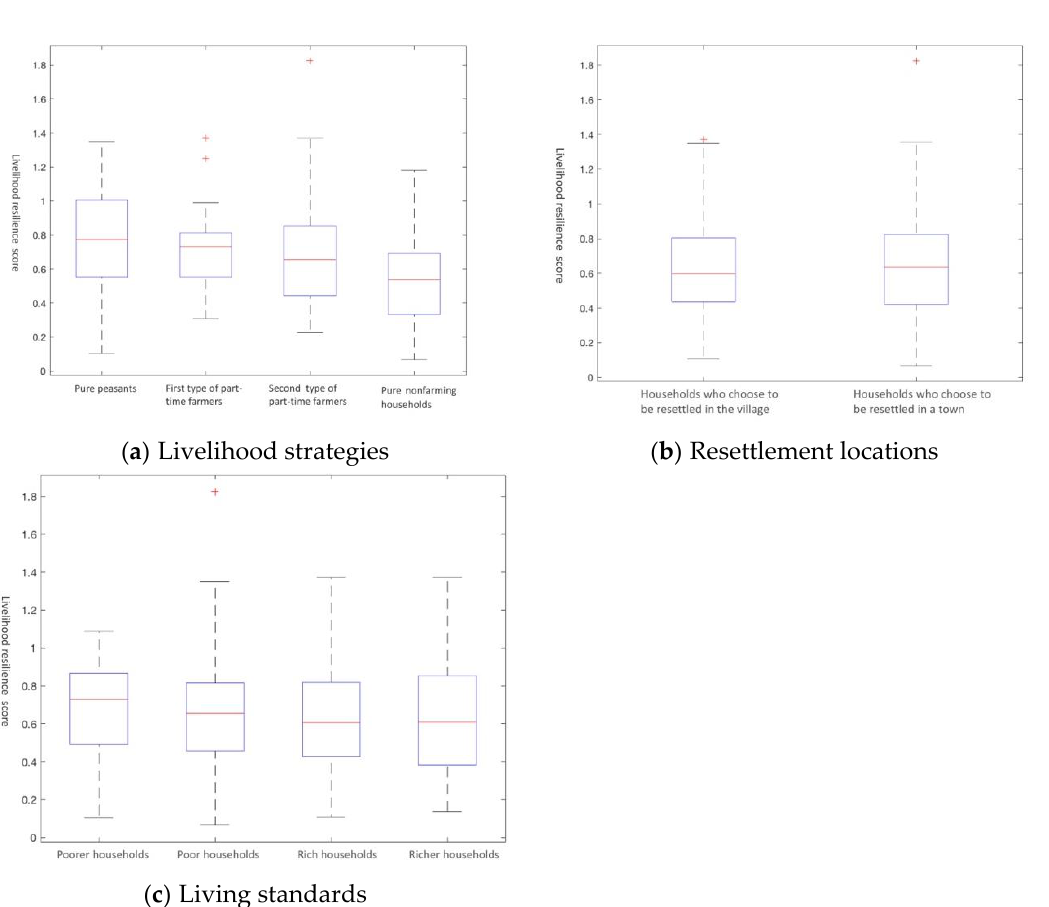
Overall Composite Component Asset Individual Indicators Asset Index Indexes Overall livelihood Natural capital Farmland, farm crops, livestock, soil erosion capital Physical capital Road conditions, irrigation facilities, services Family neighbors, group political influence